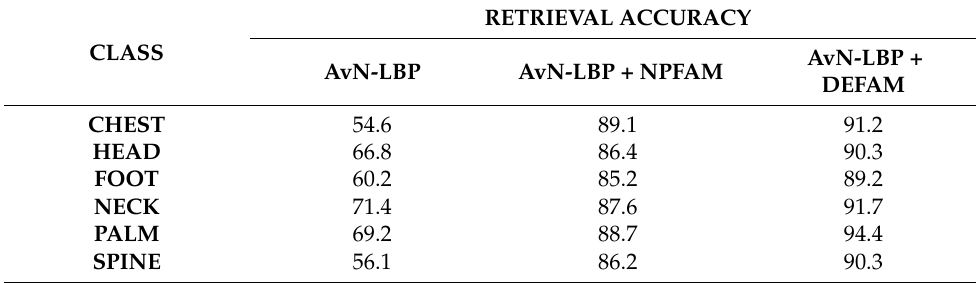
Table 7. Percentage accuracy achieved by MIR Systems on the database of human parts for the top 25 retrieved